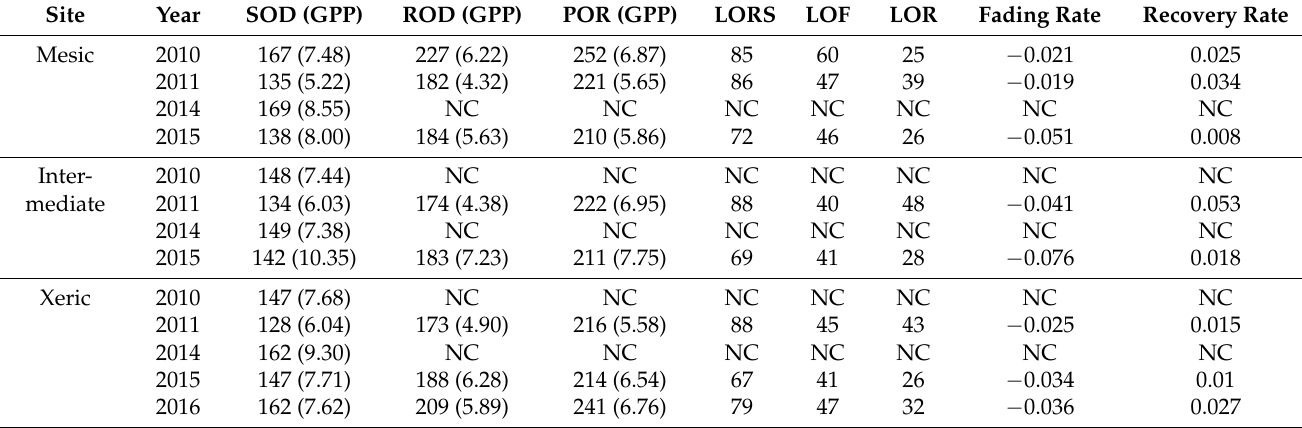
Table A4. Post-drought ecosystem phenology by site: SOD = start of disturbance (d), ROD = recovery day of disturbance (d), POR = peak of recovery (d), LORS = length of response to stabilization (d), LOF = length of fading (d), LOR = length of recovery